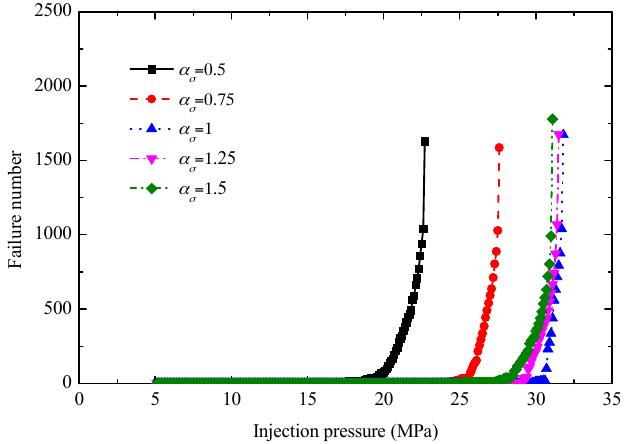
Figure 14. Change of failure number with stress ratio during nitrogen fracturing.